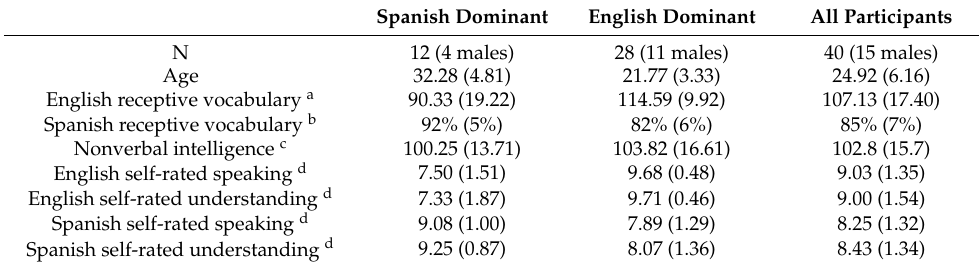
Table 1. Participant Characteristics: Mean